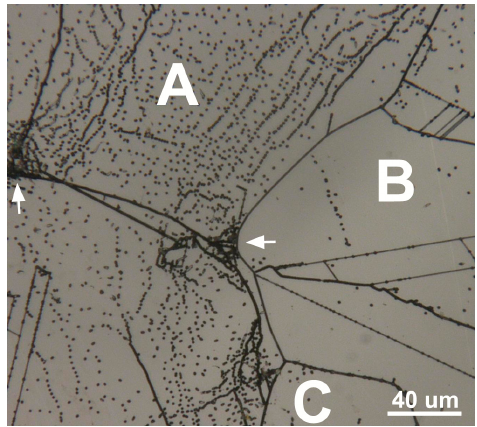
Figure 3. Image of grains with different dislocation densities from one grain to another. As indicated by black arrows in Figure 2b, some dense dislocation clusters emanate from the grain boundaries. In Figure 4 with higher magnification, as indicated by the white arrows, this phenomenon can be better observed. This suggests that grain boundaries can be one of the dislocation generation sources. These dislocations are mostly slip dislocations, and they should be generated during the solidification stage due to the thermal stress originating from the neighboring grains [19].